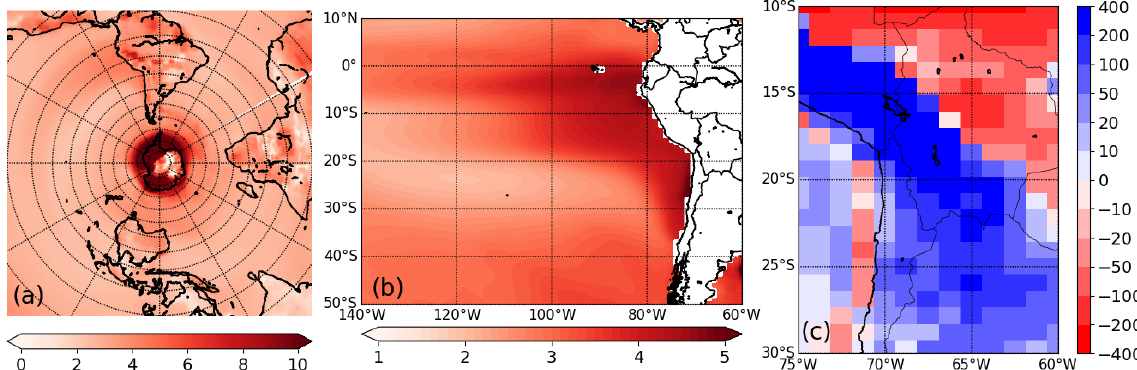
Figure 2. Changes (mid-Pliocene minus historical) for mean annual (a) near-surface air temperature (at 2m above ground in ◦ C), (b) sea- surface temperature (in ◦ C) and (c) rainfall (in mmyr − 1 ) as simulated by the global CESM2 model. Table 1. Proxy data for wetter conditions in the region of the Atacama Desert that fall into the mid-Pliocene. Name of site Coordinates Time period Type of proxy data Signal relative to present- day conditions